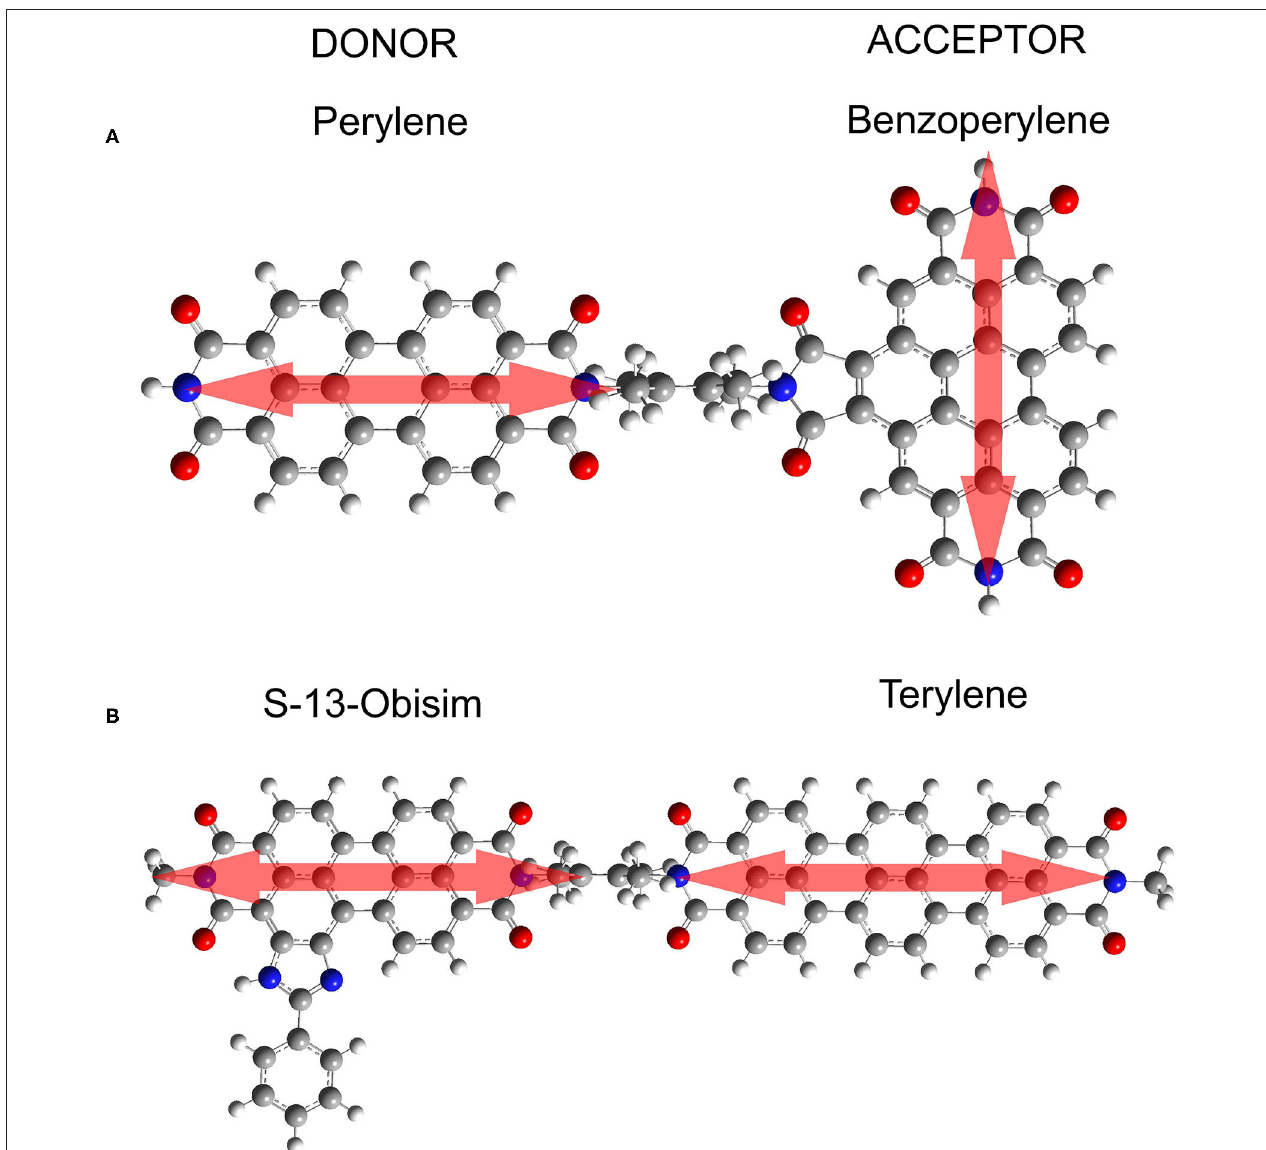
FIGURE 1 | Simulated donor-acceptor systems. (A) Perylene-benzoperylene bisimide dyad in orthogonal arrangement. The distance between centers of the transition charge centroids is 16 Angstrom. (B) S-13-obisim-terrylene dyad in parallel arrangement.